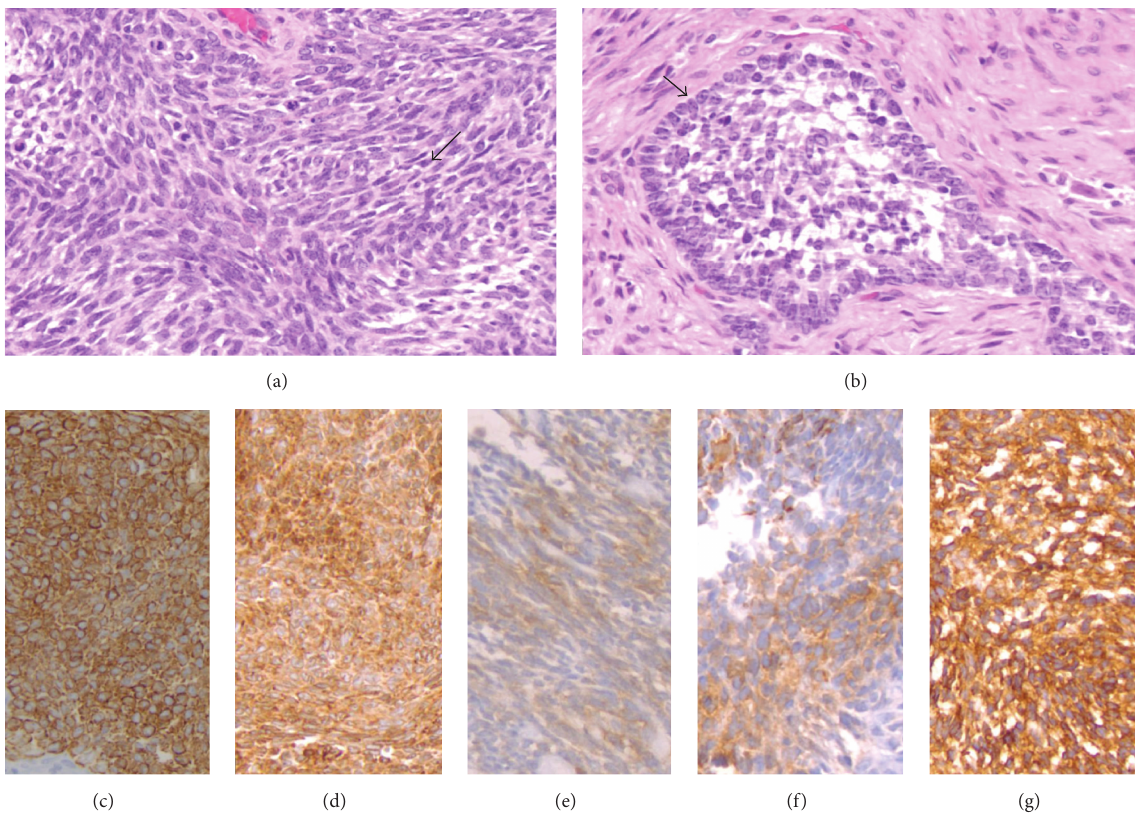
Figure 2: (a) Predominant spindle cell pattern; see arrow (H&E). (b) Basaloid pattern with peripheral palisading; see arrow (H&E). (c) CK5/6 strong positive. (d) BCL-2 positive. (e) CD117 focal positive. (f) VEGF focal positive. (g) EGFR diffuse